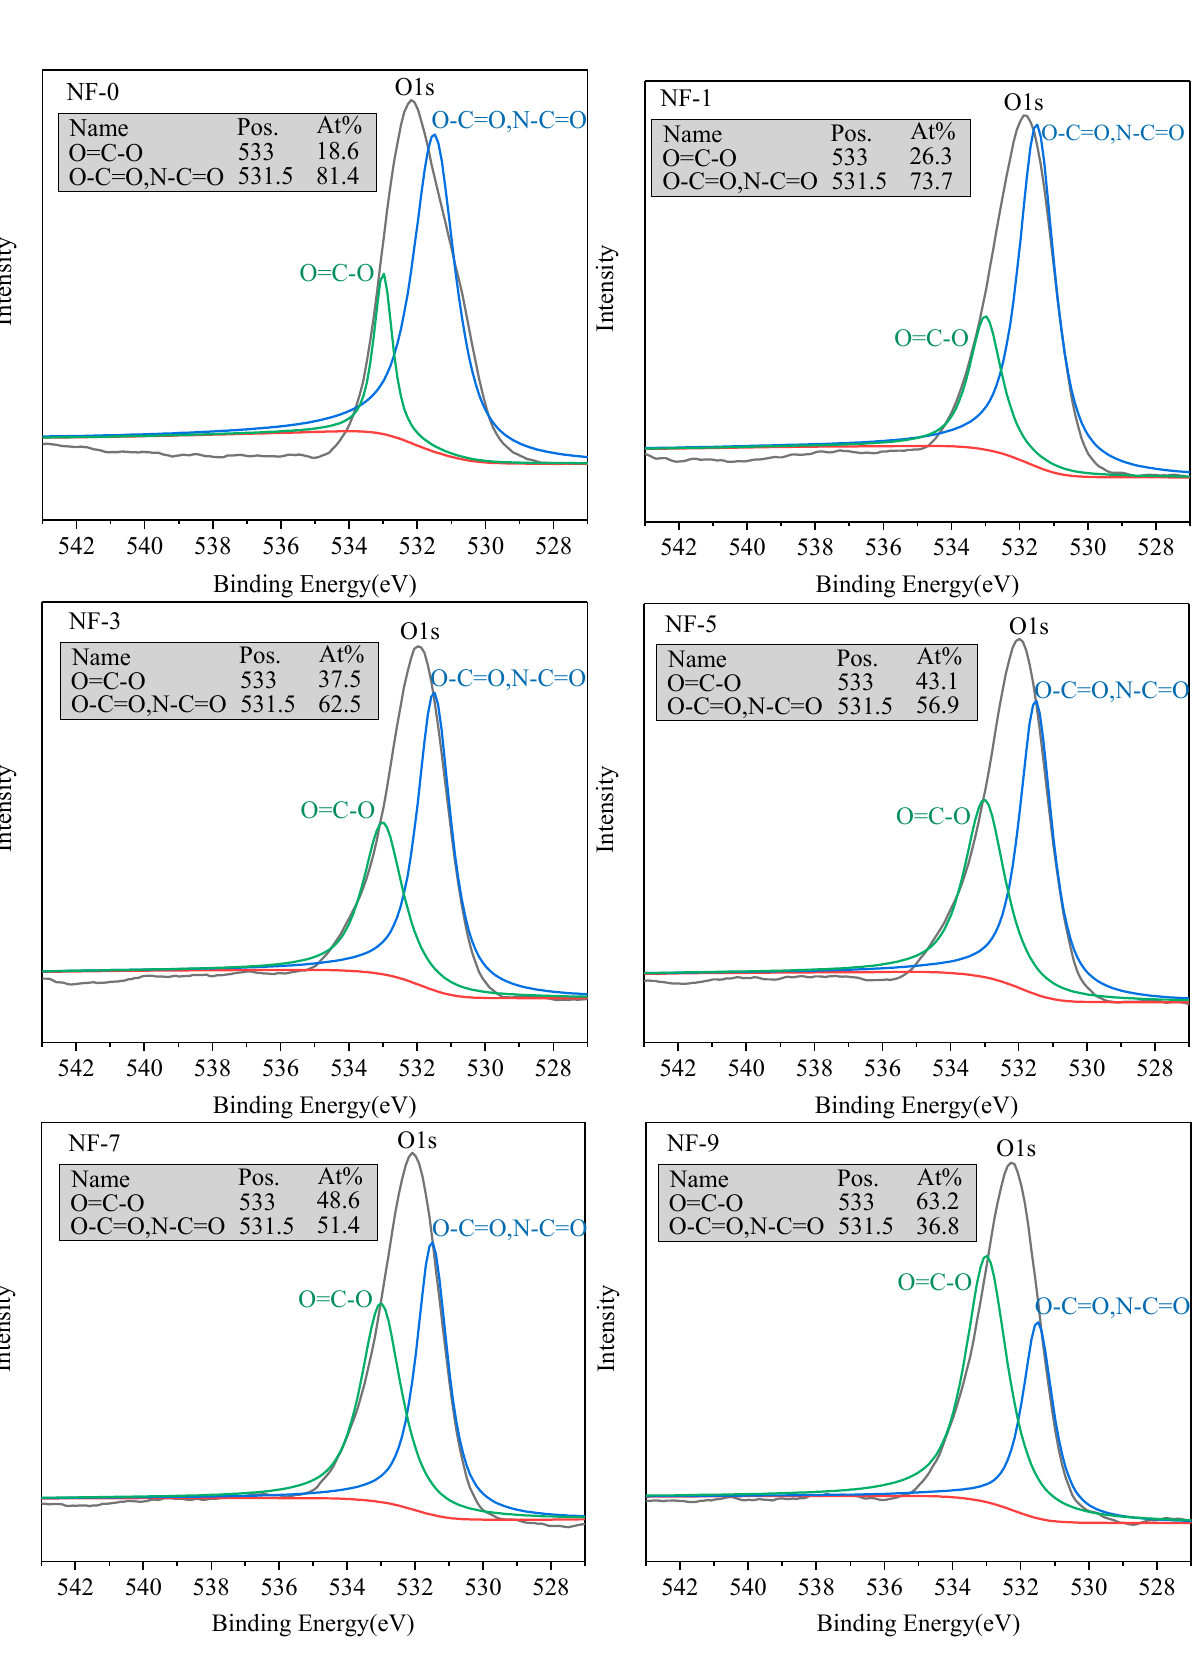
Figure 4. Oxygen 1s XPS spectra of NF membranes with different DWCNT dosages. Zeta potential is used to characterize the electric charge on the membrane surface [21]. The variation trend of membranes’ zeta potential for different DWCNT dosages is